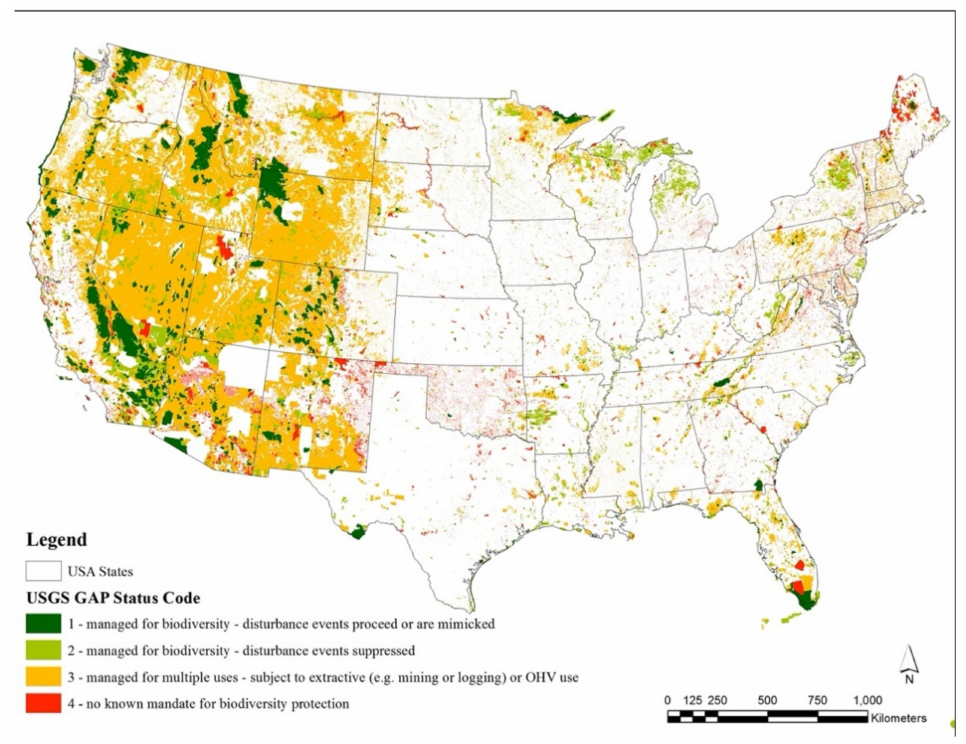
Figure 5. Protected Areas Dataset for CONUS, including GAP status lands